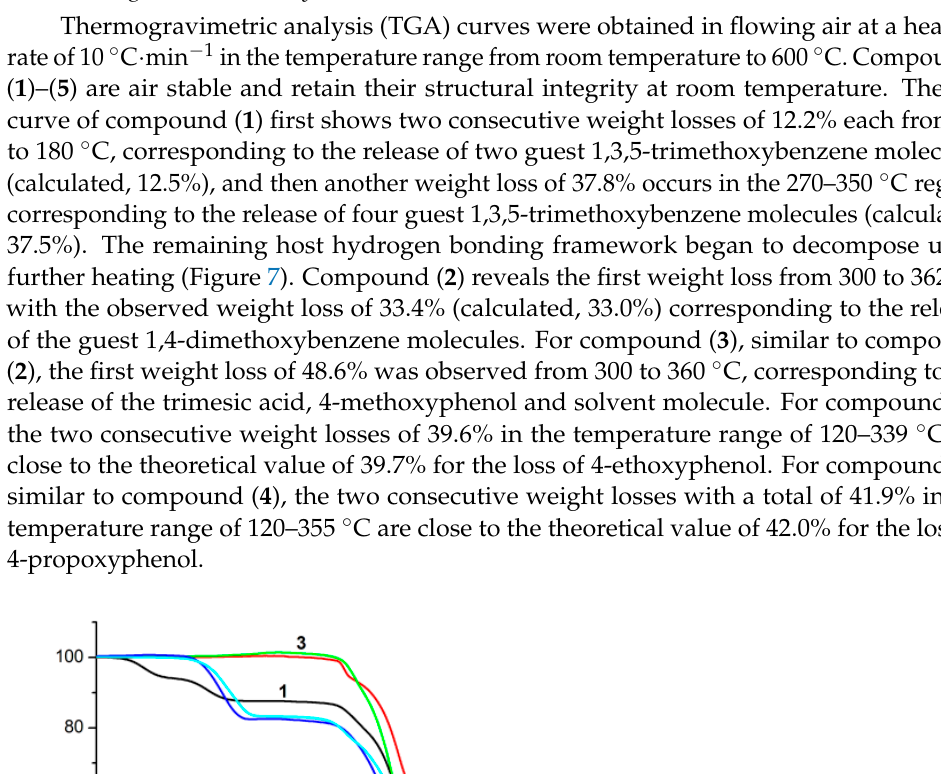
Figure 6. One-dimensional hydrogen-bonded chain along the a axis in compounds ( 4 ) and ( 5 ).